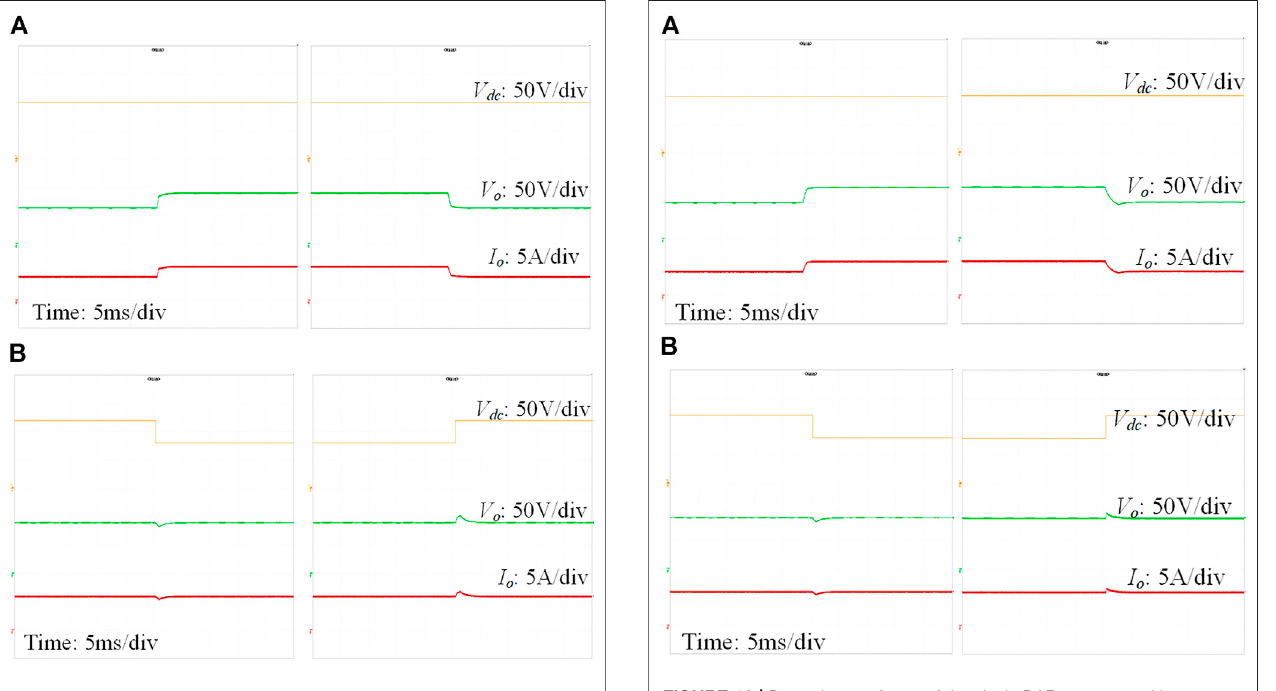
fi lter. The circuit parameters are shown in Table 2 . The equilibrium point can be derived by solving 15) making _ x (cid:1) 0 . So the steady-